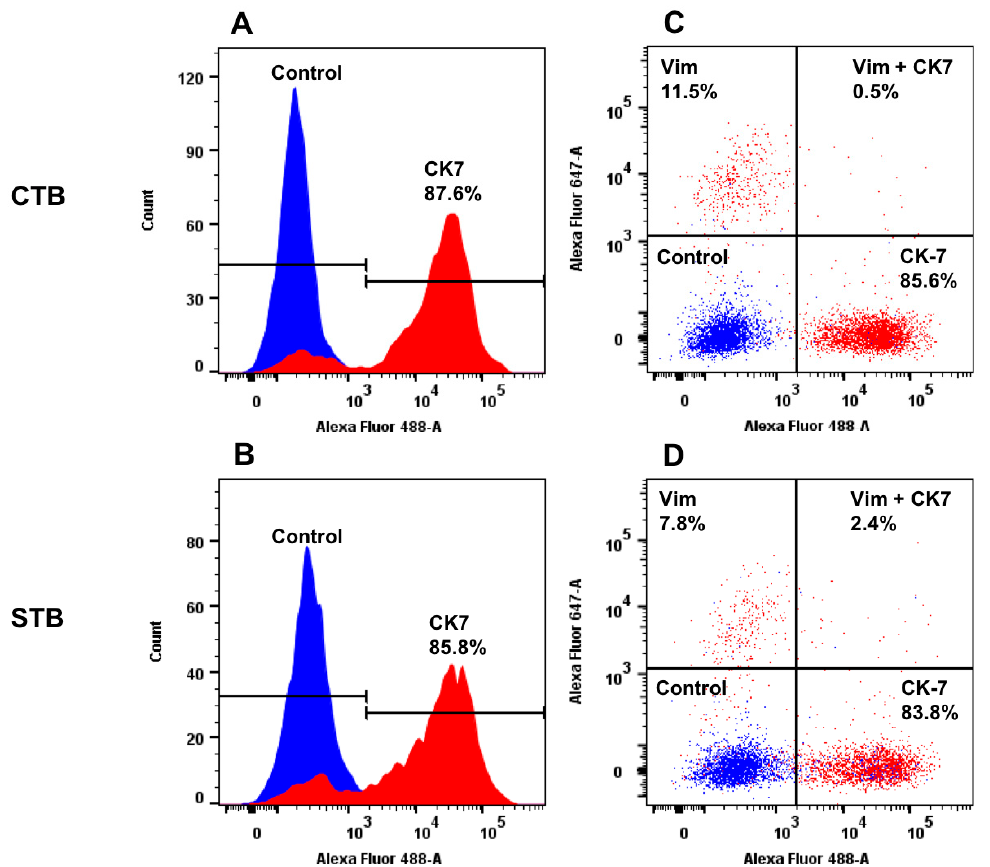
Figure 2. Protein expression of cell-specific markers in CTB and STB cultures. Protein expression of cytokeratin (CK) 7 and vimentin (vim), specific markers for epithelial cells and mesenchymal cells, respectively. ( A – D ): Representative protein expression patterns of CK7 and vim in isolated trophoblasts after 24 h (undifferentiated trophoblasts; CTB, panel ( A ) and ( C )) and 72 h (differentiated trophoblasts; STB, panel ( B ) and ( D )) of cultivation was assessed by flow cytometry. Specific staining of CK7 and vimentin is depicted in red; the isotype control staining is shown in blue. The images are shown as overlays on isotype control. The black lines on panels A and B indicate the positive (CK-7) and negative (isotype control) expression patterns. Data were evaluated by using FlowJo data analysis software.